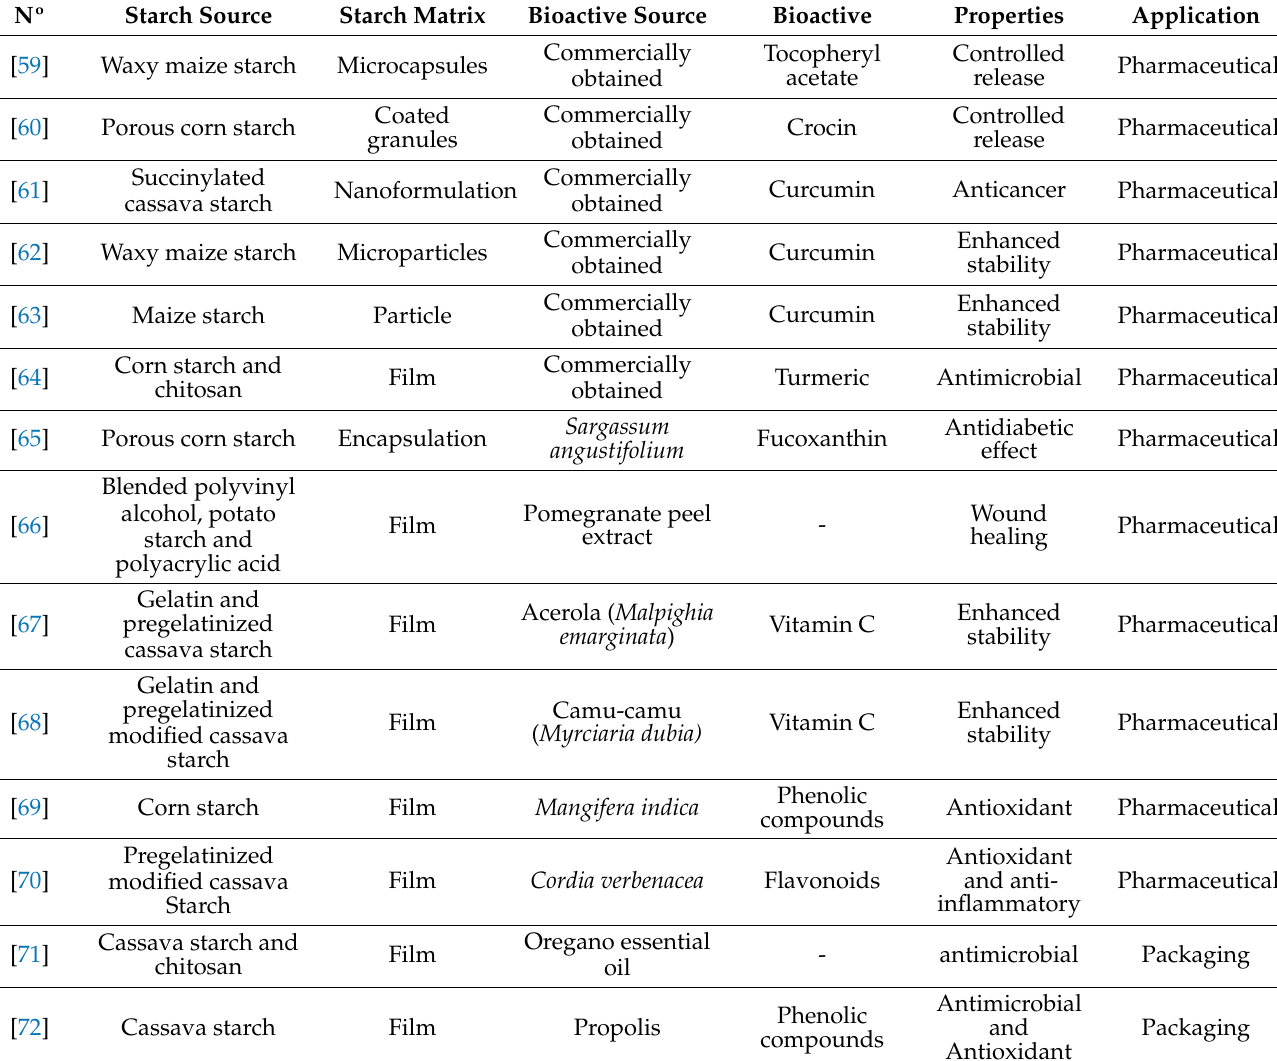
Table 1. Summary of starch matrices incorporated with bioactive